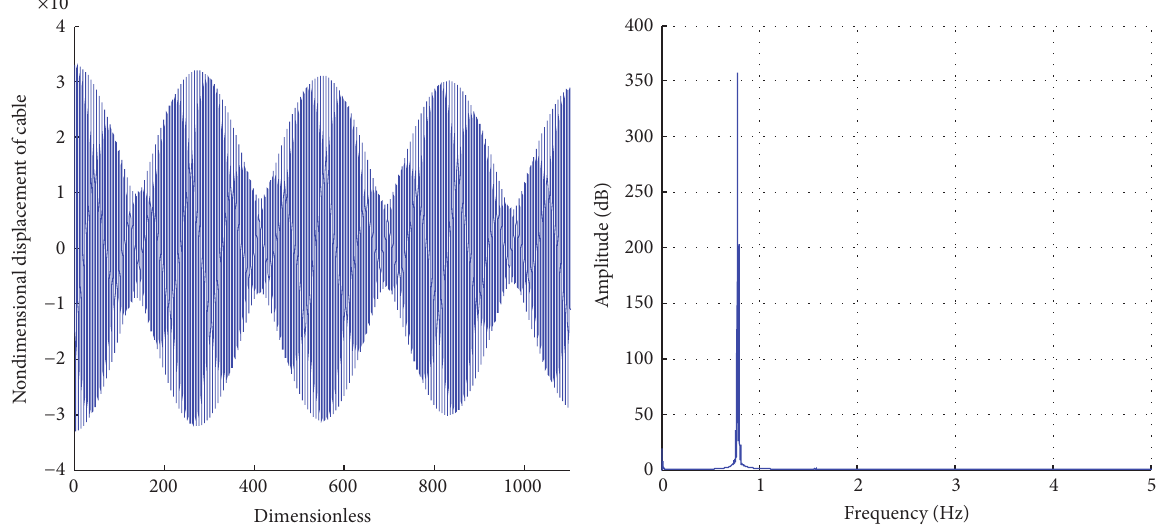
Figure 3: Dimensionless displacement response time history and amplitude-frequency characteristic curve of the deck beam